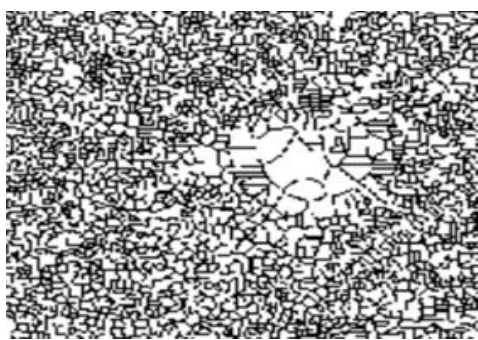
Figure 11. Original pleiades image